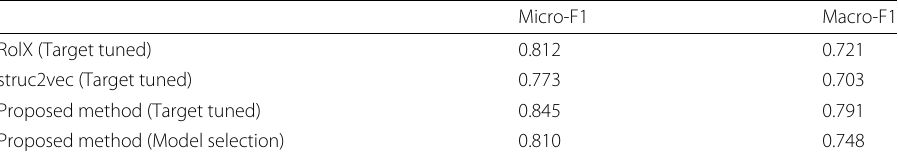
Table 2 Classification results after operation Micro-F1 Macro-F1 RolX (Target tuned) 0.812 0.721 struc2vec (Target tuned) 0.773 0.703 Proposed method (Target tuned) 0.845 0.791 Proposed method (Model selection)